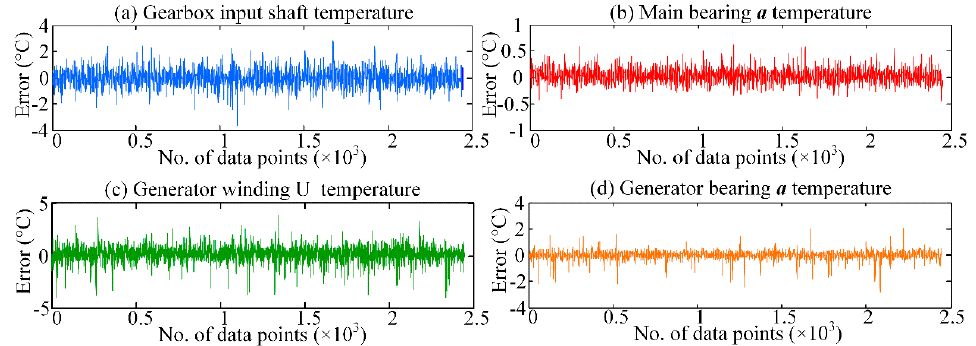
Figure 10. Error residuals for the prediction models of four component temperature parameters. ( a ) Gearbox input shaft temperature; ( b ) Main bearing a temperature; ( c ) Generator winding U temperature; and ( d ) Generator bearing a temperature.